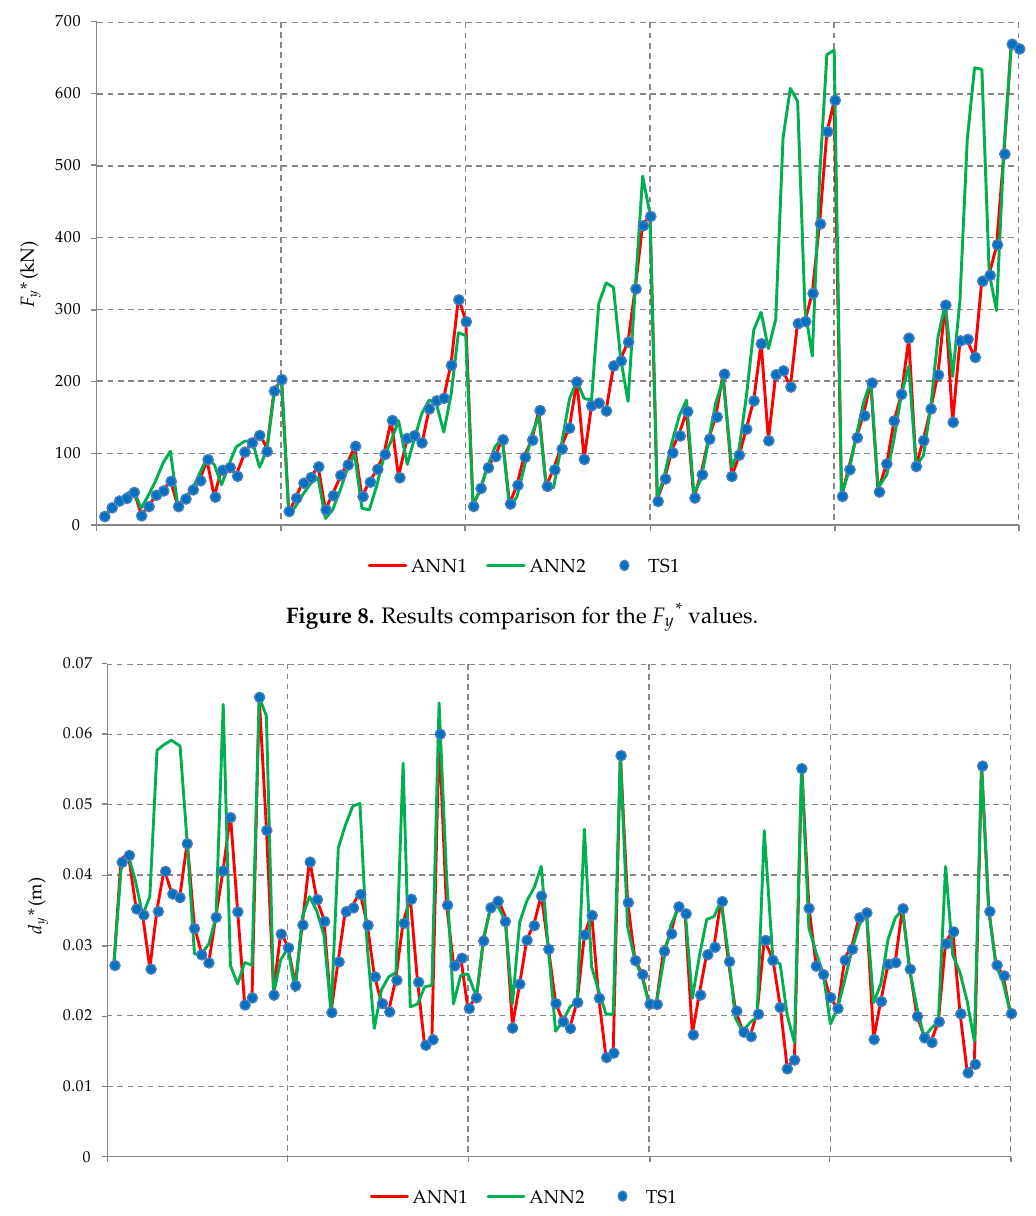
Figure 9. Results comparison for the d y* values.